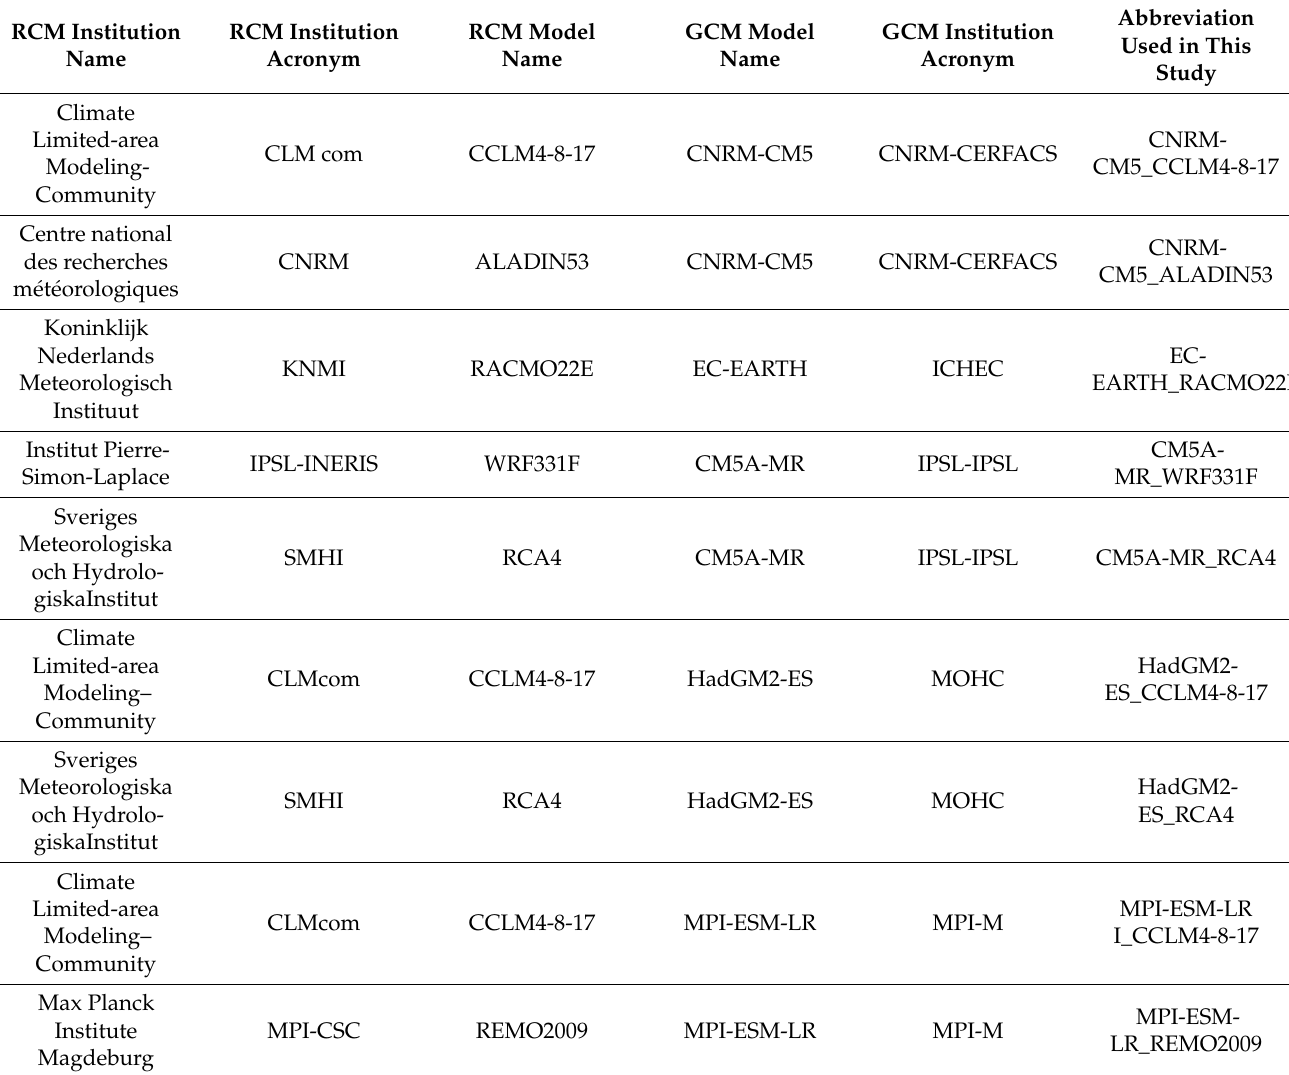
Table 2. CORDEX multi-model datasets abbreviation used in this